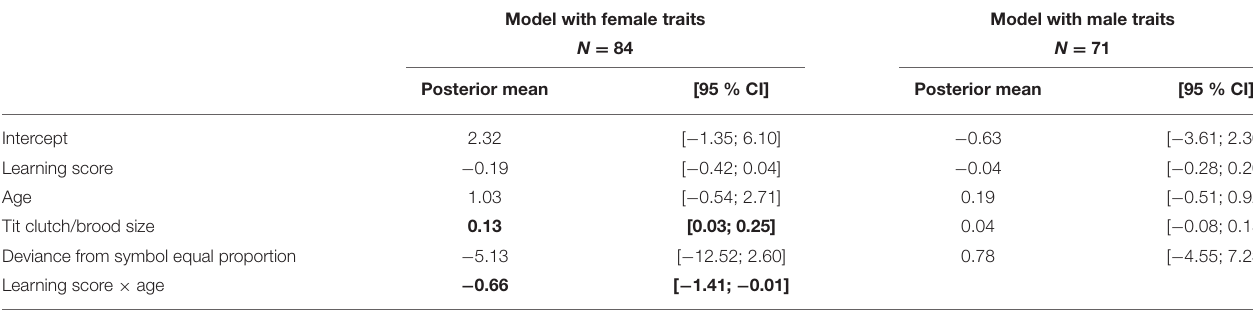
TABLE 2 | Influence of individual’s age and learning score on the probability to copy tit preference.